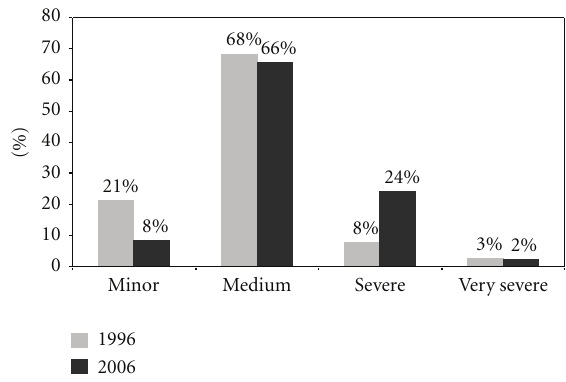
Figure 5: Abdominal pain in women with dysmenorrhea 1996 and after menopause